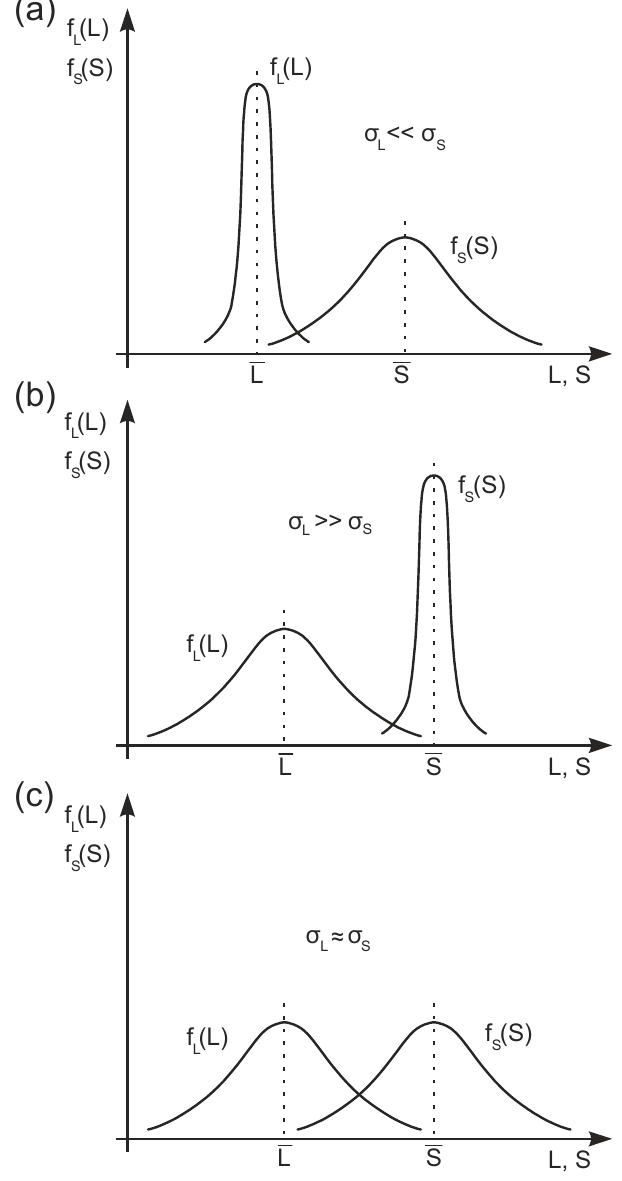
Figure 3. Functions of load (exposure) probability density f L ( L ) and element’s strength f S ( S ) for the three cases of their relation under consideration (cases ( a – c ) are discussed in the text).